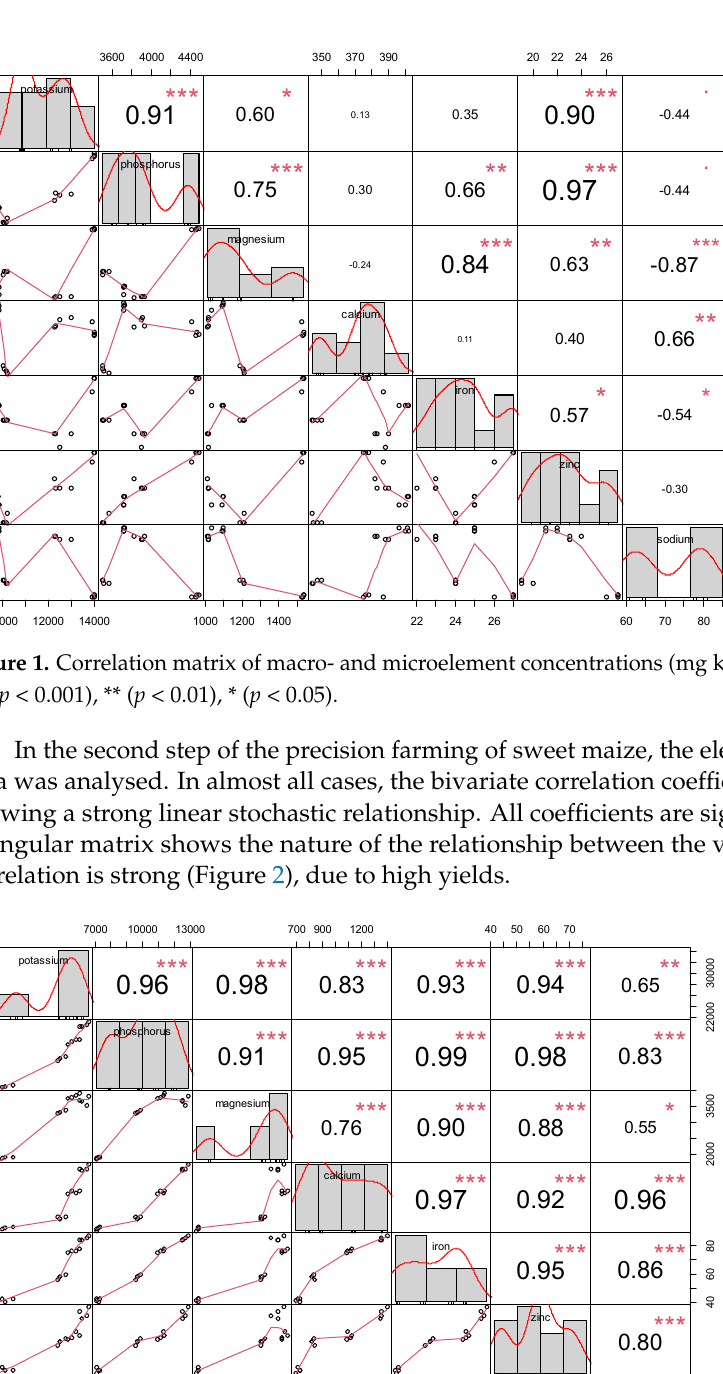
show a moderately strong correlation. All coefficients are significant. The lower triangle matrix shows the nature of the correlation between the variables. The positive linear cor- relation between fructose and glucose is strong. However, the relationship between fruc- tose and sucrose and between glucose and sucrose suggests a parabolic correlation. For this reason, the linear correlation coefficients are low (Figure 3).